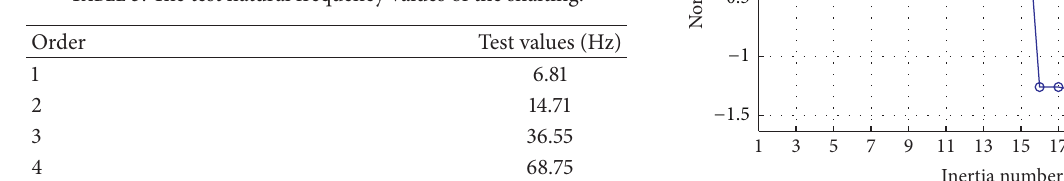
Table 3: The test natural frequency values of the shafting.